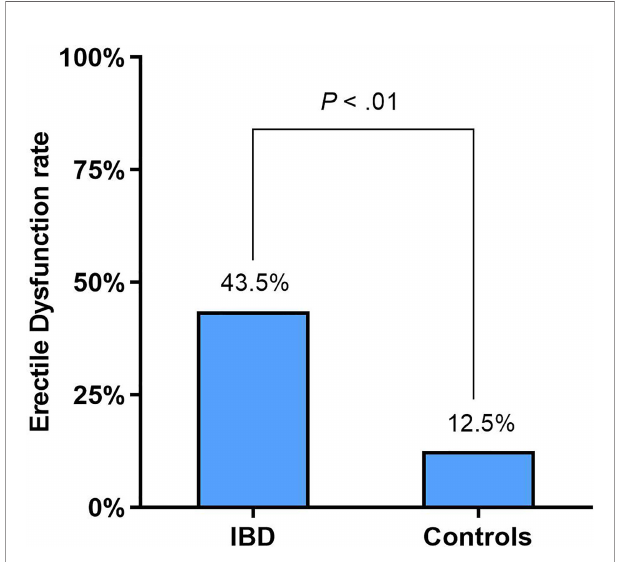
FIGURE 2 | Erectile function of IBD male patients compared with healthy controls according to